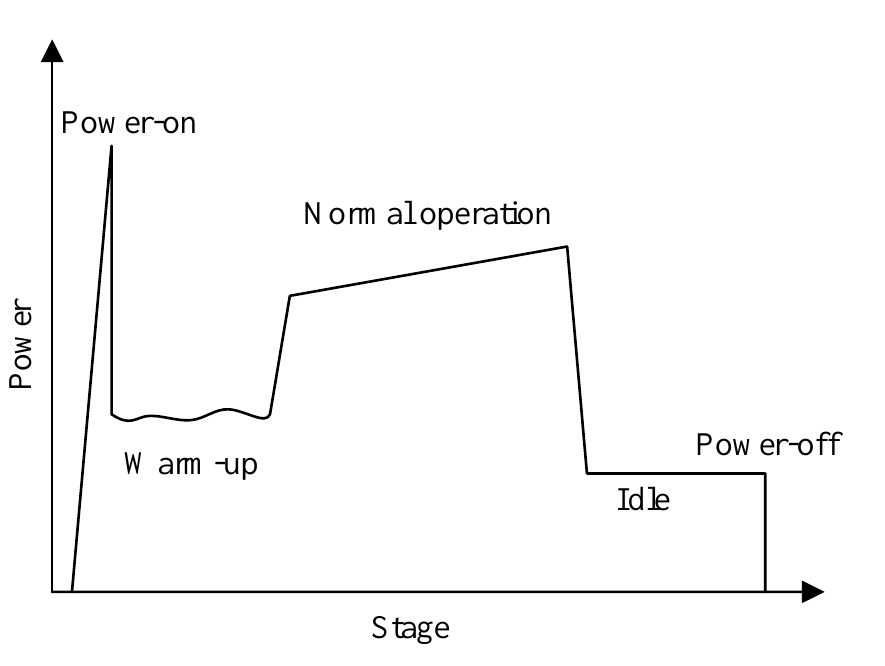
Figure 3. Different energy consumption states of equipment.